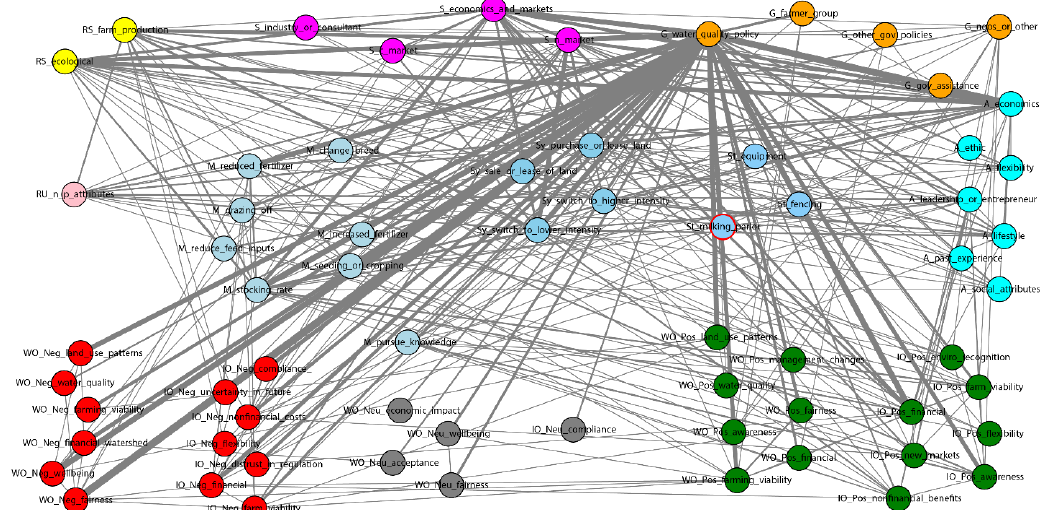
Figure A1.2. Taupo SES sub-category group mental model